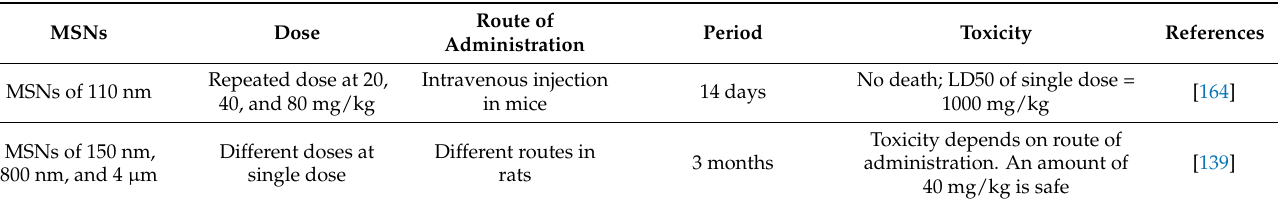
Figure 13. Schematic representation of the intact and degraded structures of silica material nanopar- ticles with the mechanisms and regulating factors underlying degradation. Reproduced from [155], WILEY-VCH Verlag GmbH and Co. KGaA, 2017. Table 4. The toxicity and biosafety of MSNs of various size, shape, surface modification, and route of administration in in vivo